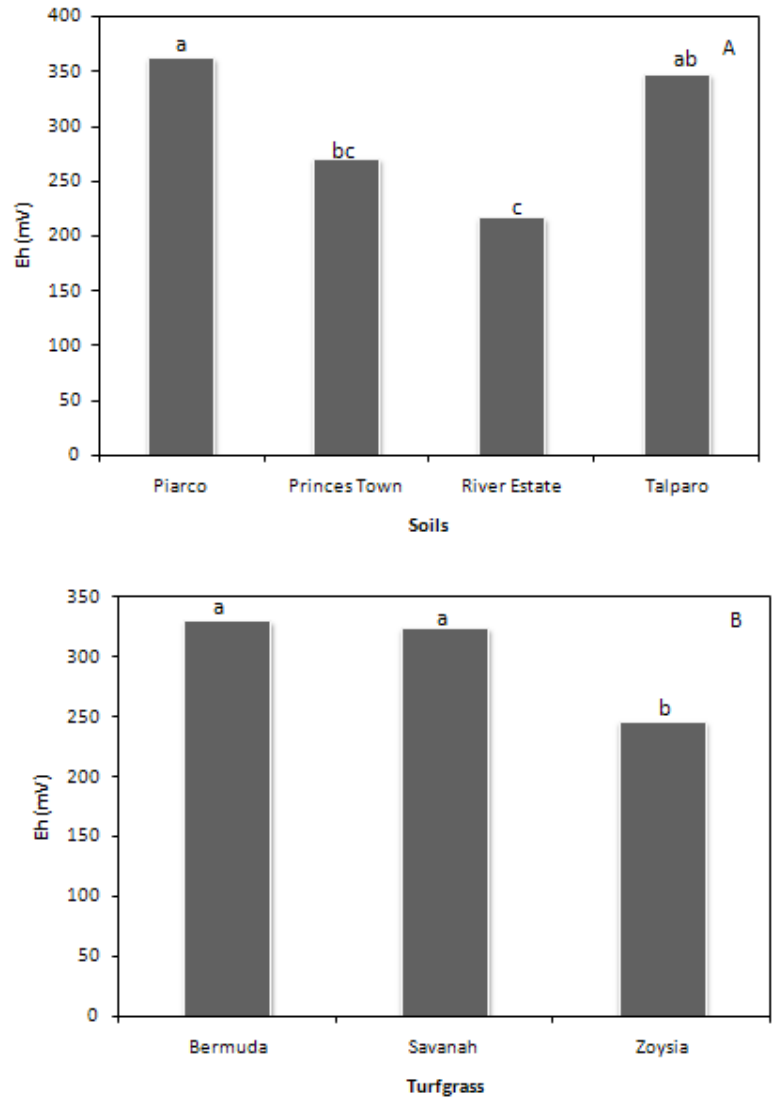
Figure 3. The main effects of soil ( A ) and turfgrass ( B ) on root zone